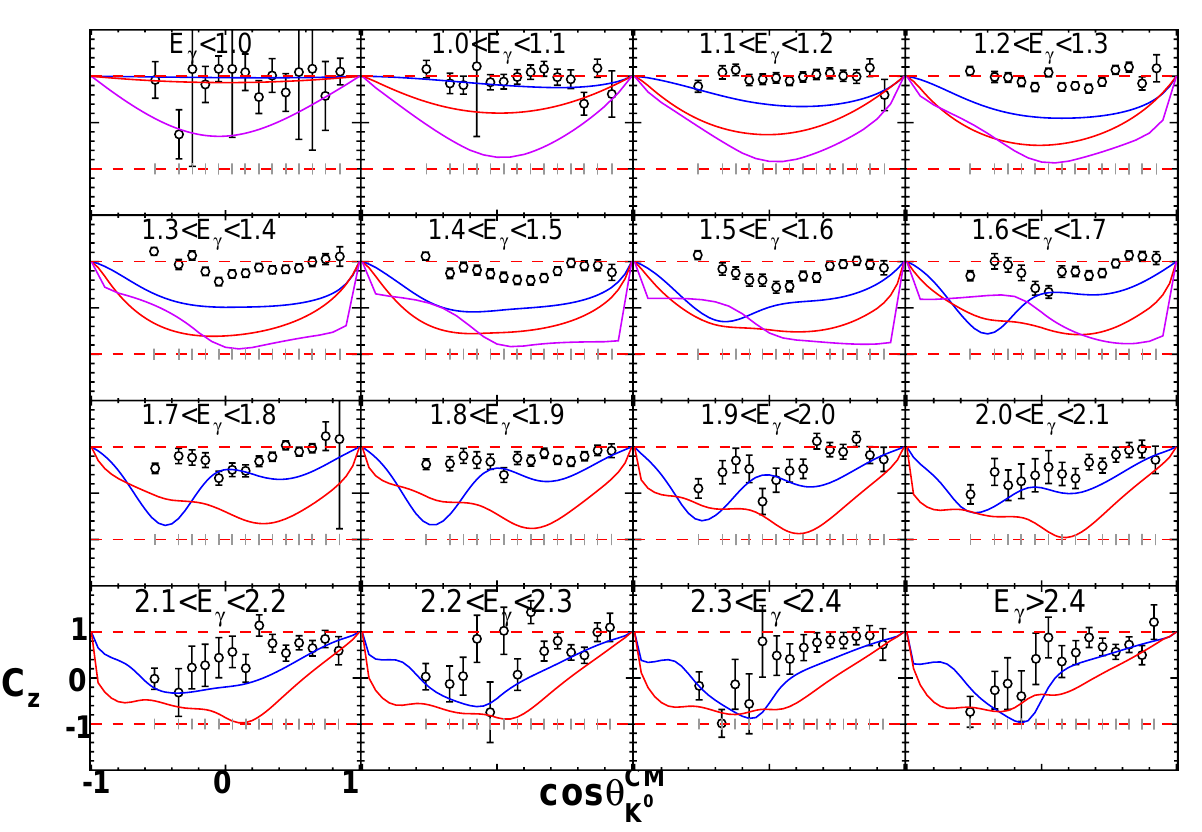
Figure 3. Preliminary K 0 -angular distributions of the polarization-transfer observable C z in the γ d → K 0 Λ ( p ) reaction (open circles) [42, 44]. The panels show results from various photon-energy bins where the maximum energy is about 2.6 GeV. The preliminary data are compared with analysis solutions. The blue and the red curves show results from the BnGa group; the pink curve is from ANL Osaka